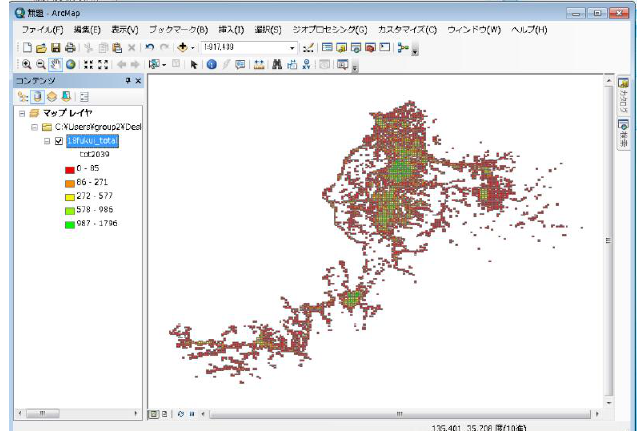
Figure 1. Future-Pop Data of Fukui Prefecture in